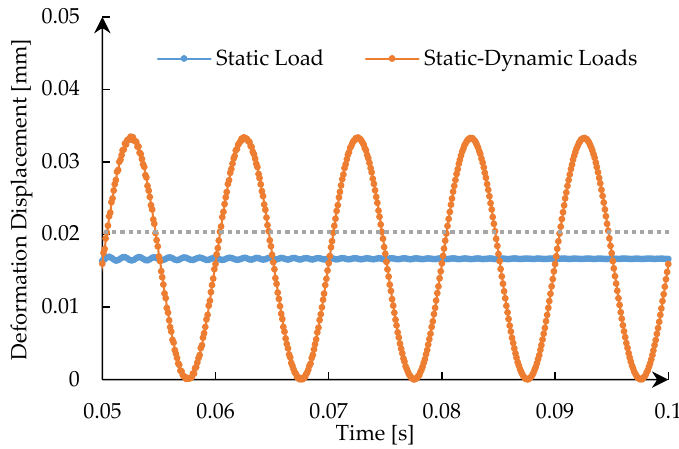
Figure 7. Numerical results showing deformation displacement versus time relationships of the rock for cylindrical indenter under two kinds of loading conditions.